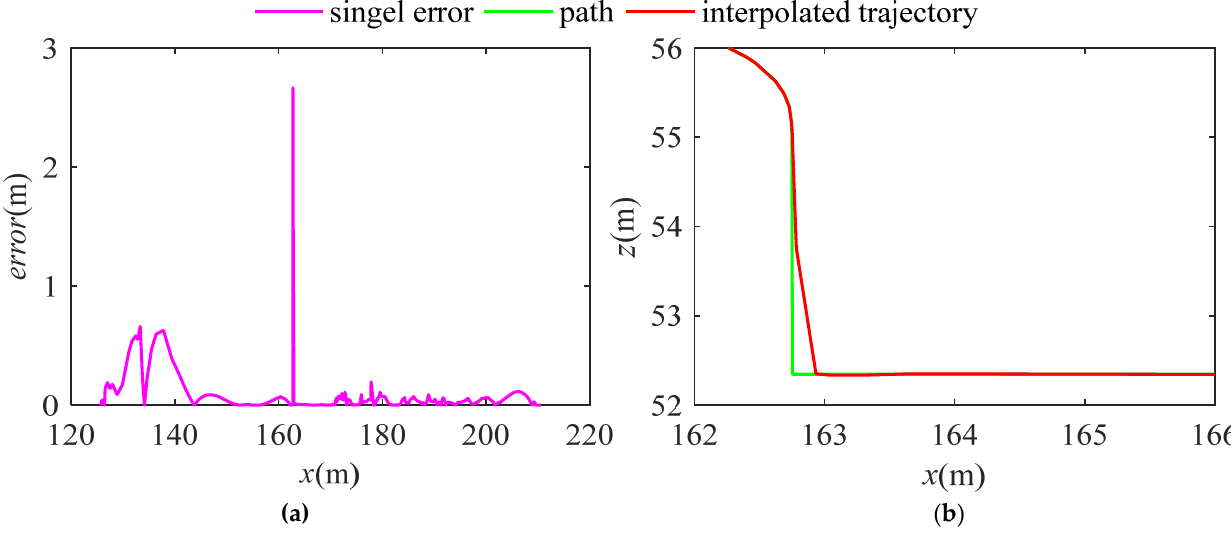
Figure 7. ( a ) The single error result between the trajectory model and the path, ( b ) The difference between the trajectory model and the path in the vertical descent region.